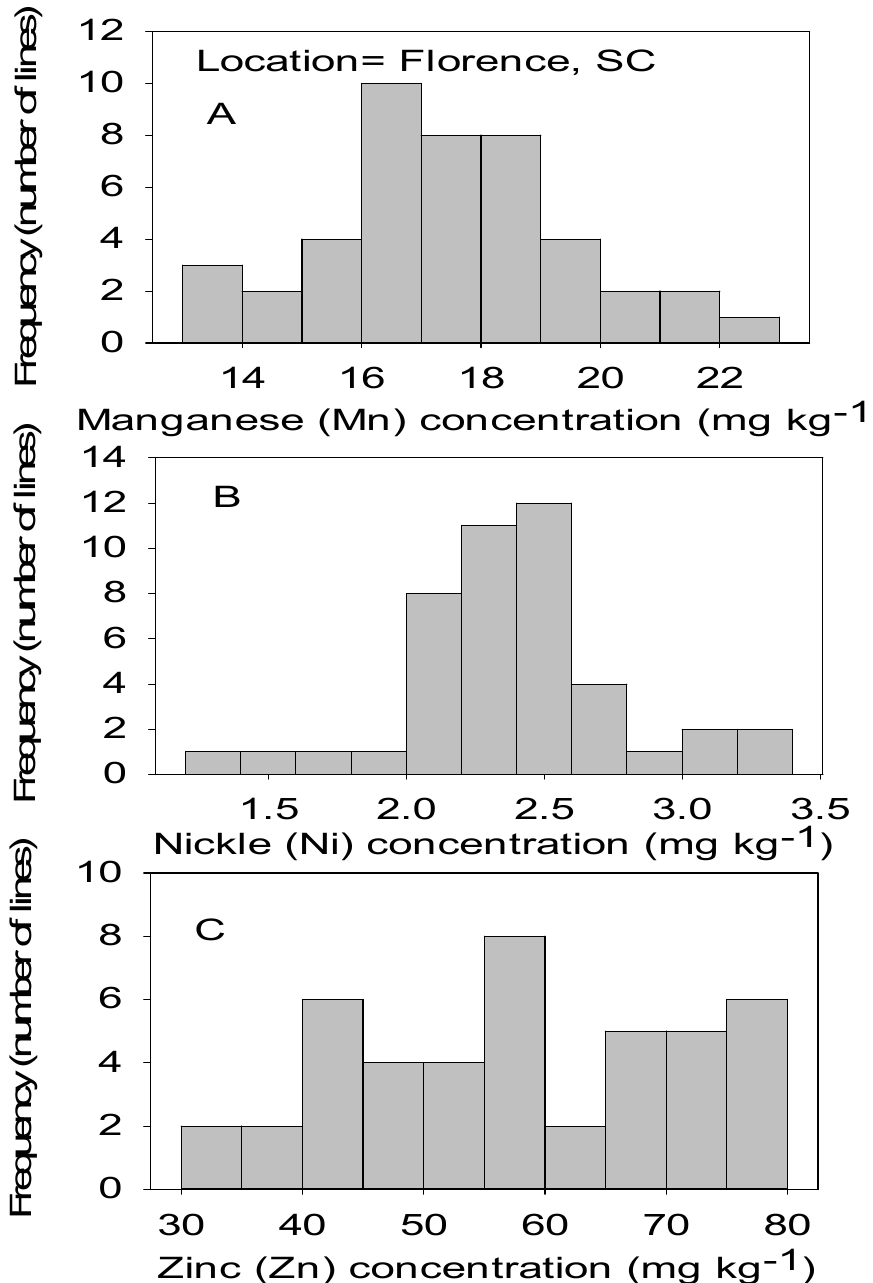
Figure 2. Distribution of micronutrients Mn ( A ), Ni ( B ), and Zn ( C ) in cottonseed in chromosome substitution lines (CS) in cotton in Florence, SC, USA.